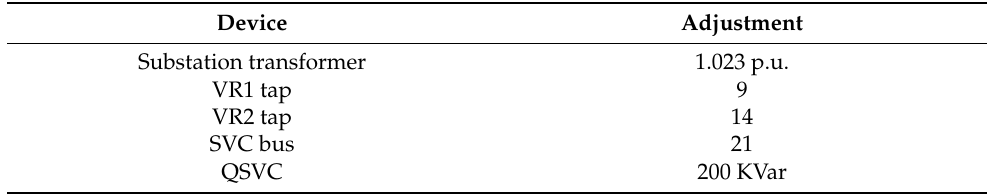
Table 4. Voltage regulating devices setting in the second stage.